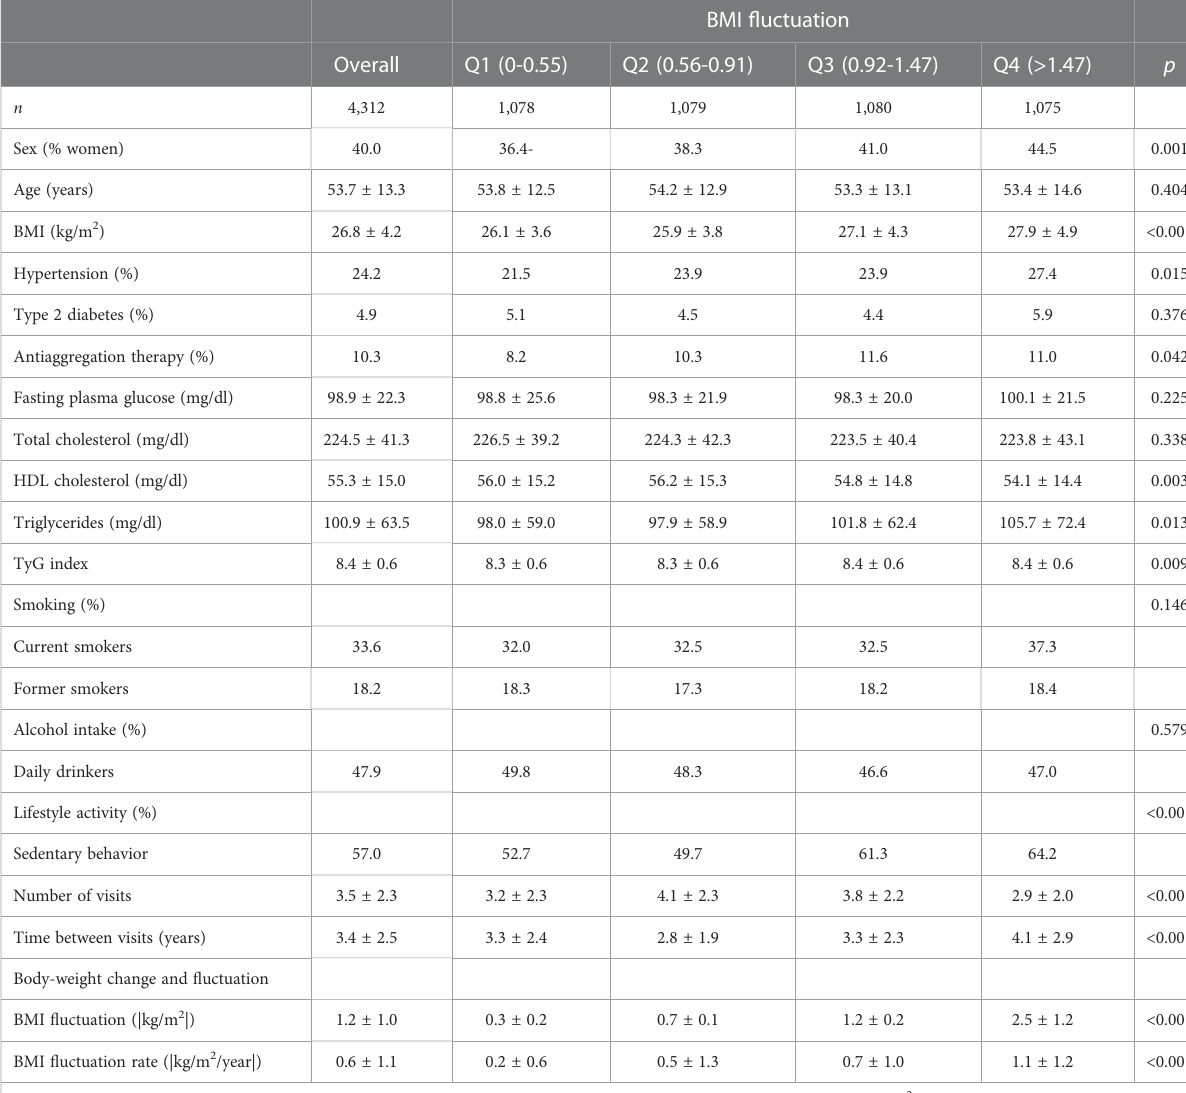
TABLE 1A Baseline demographics and risk factor pro fi les according to quartiles of body mass index (BMI) fl uctuation (|kg/m 2 |) of 4,312 participants drawn from the VMCUN clinical cohort between 1997 and 2015 in